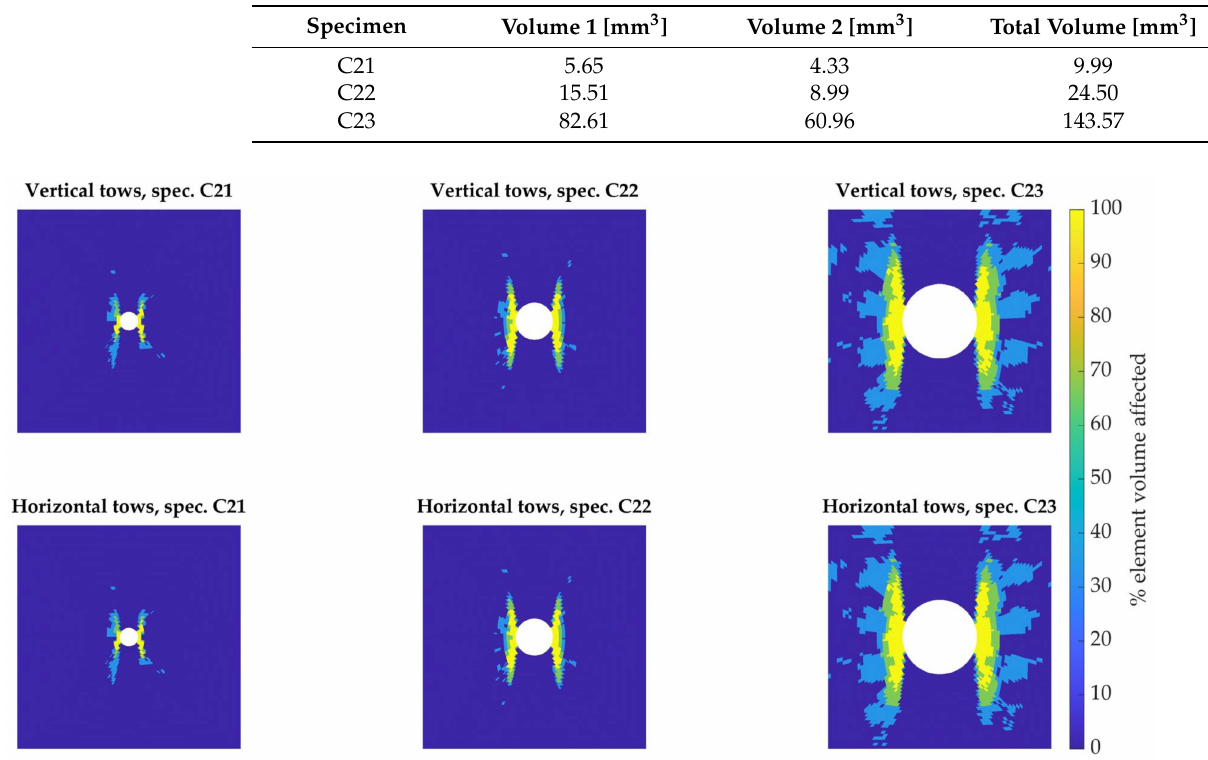
Figure 8. Maps showing the percentage of the volume of material per element in the two orientations, the longitudinal stress of which surpasses the remote one, in the proximity of the hole. Remote stress was calculated as the maximum stress in a portion of the specimen away from the stress